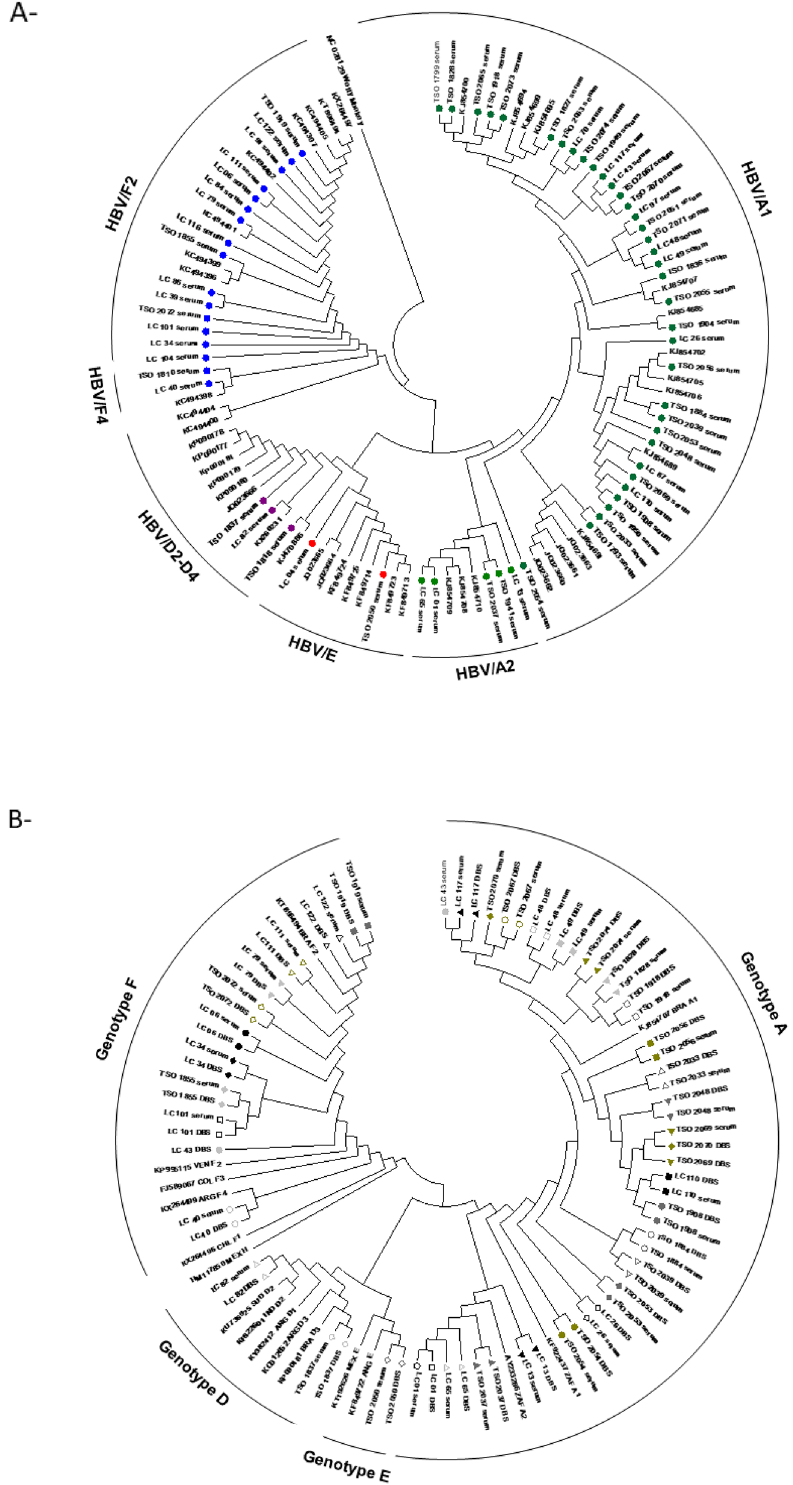
Figure 2. Phylogenetic analysis based on HBV S/Pol sequences performed by using the maximum likelihood method. ( A ) Phylogenetic tree composed by 108 HBV isolates, including 58 serum samples sequenced in this study. Green dots: HBV/A sequences; blue dots: HBV/F sequences; purple dots: HBV/D sequences; red dots: HBV/E sequences. ( B ) Phylogenetic tree composed by 90 sequences, including 36 paired serum and DBS sequences. Serum and DBS pairs are identified by the same graphical